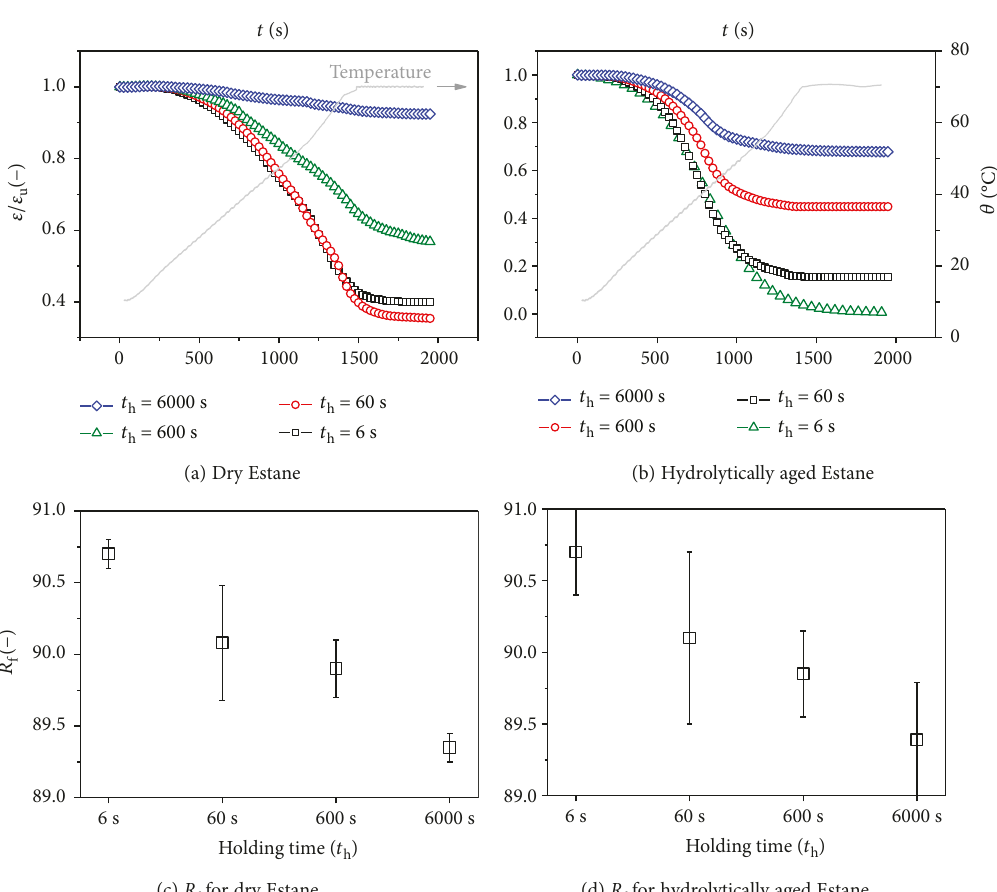
= 30% at θ = 70 ° C in a cyclic m high